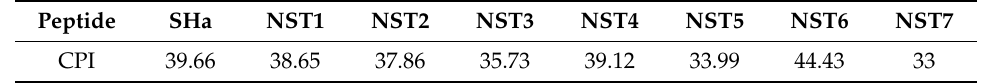
Table 4. Evaluation of insertion of temporin-SHa and its analogs into total lipids extracted from H. pylori . Total lipids from H. pylori (ATCC 43504) were used to study the interaction of temporin-SHa and its analogs with bacterial lipids as explained in Materials and Methods. Values of critical pressure of insertion (CPI) were calculated from the slopes equations in Figure 4 and are expressed in mN / m.